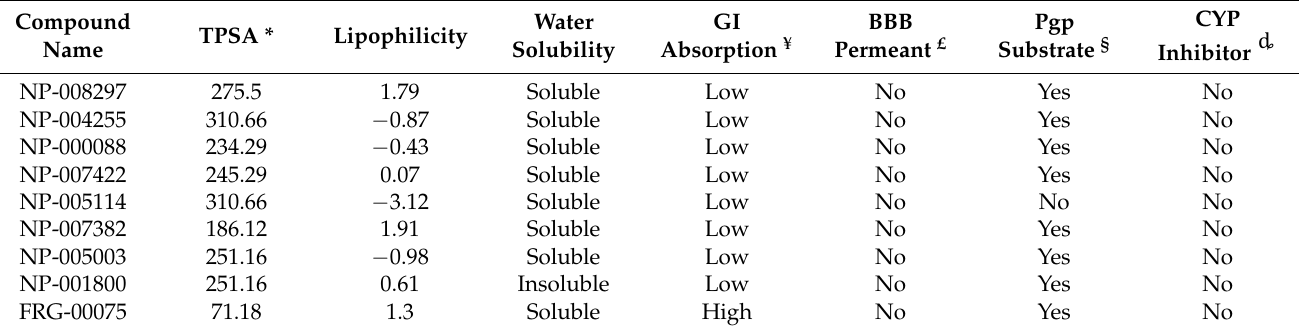
Table 6. Adsorption, distribution, metabolism, and excretion properties of the 9 selected compounds.